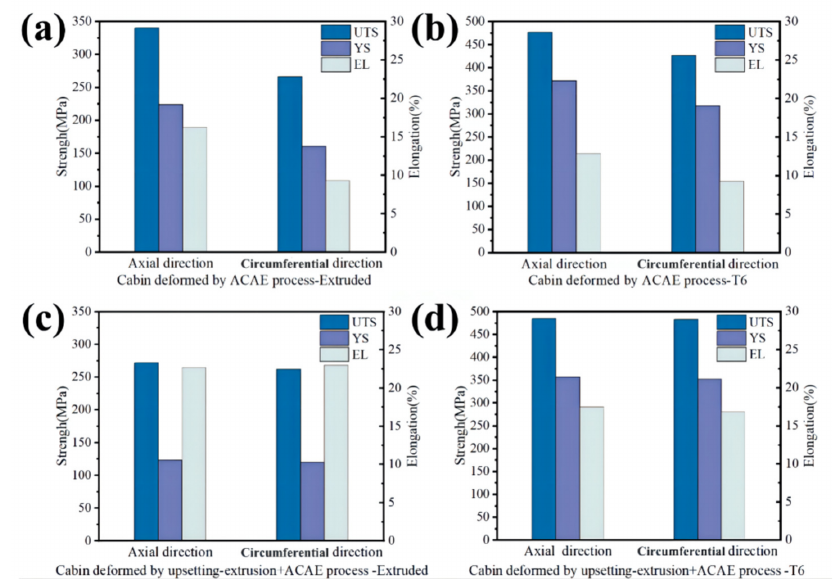
Figure 10. Tensile properties of Cabin Zone V in axial and circumscribed directions: ( a ) direct ACAE-extruded; ( b ) direct ACAE-T6; ( c ) UE + ACAE-extruded; ( d ) UE +